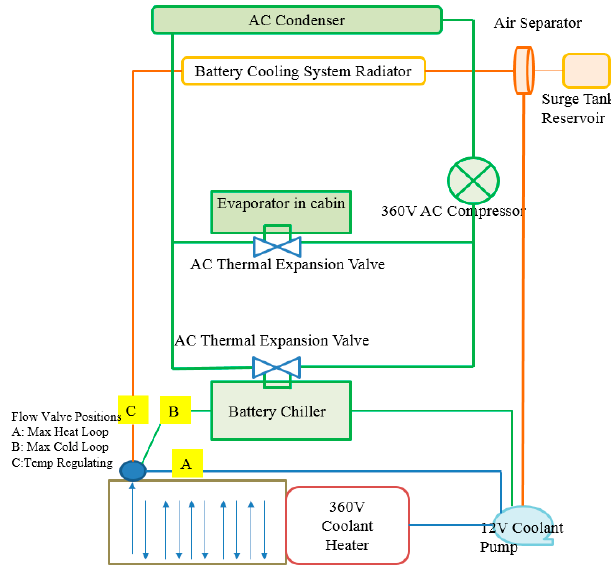
Figure 6. Sketch of the Chevrolet Volt ITM [130].